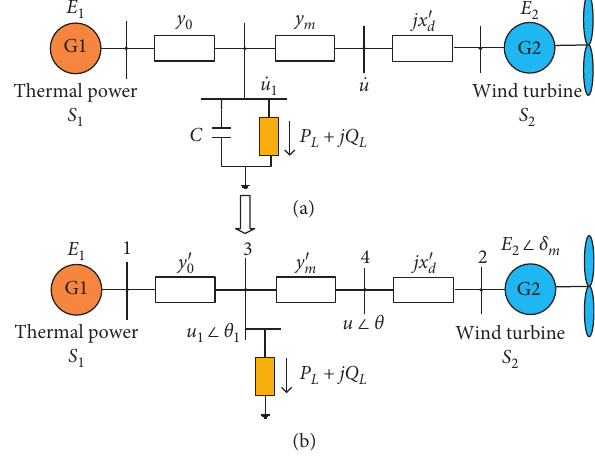
Figure 6: Equivalent circuit